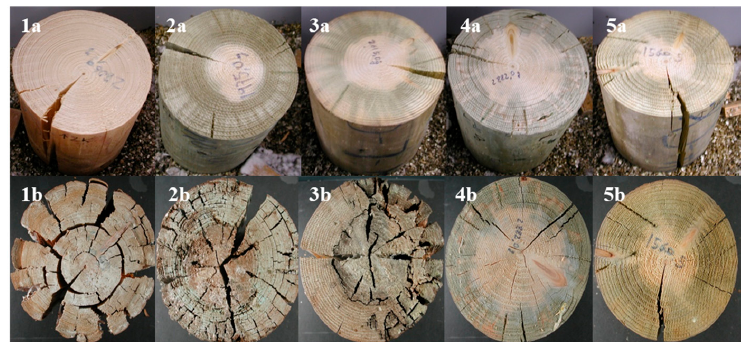
Figure 3. Effect of brown rot fungi on wood pole segments before ( 1a – 5a ) and after 24 months